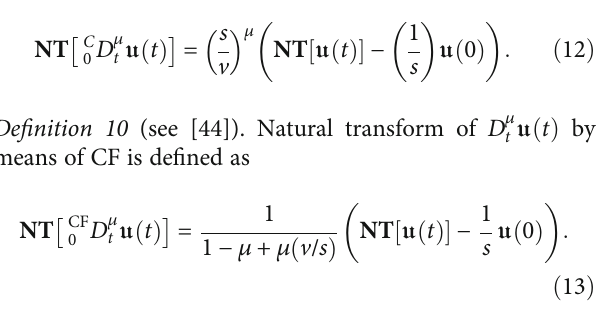
of Example 1 for μ = 1 , t = 0 : 5 , and λ = 0 : 001 ABC